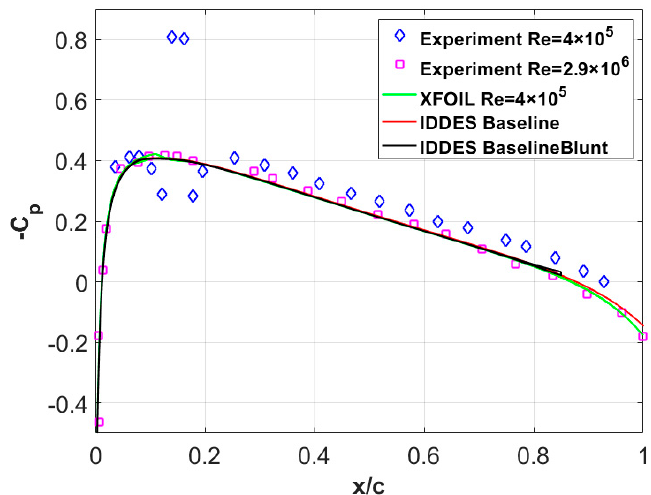
Figure 4. Comparison of the pressure-coefficient distributions.